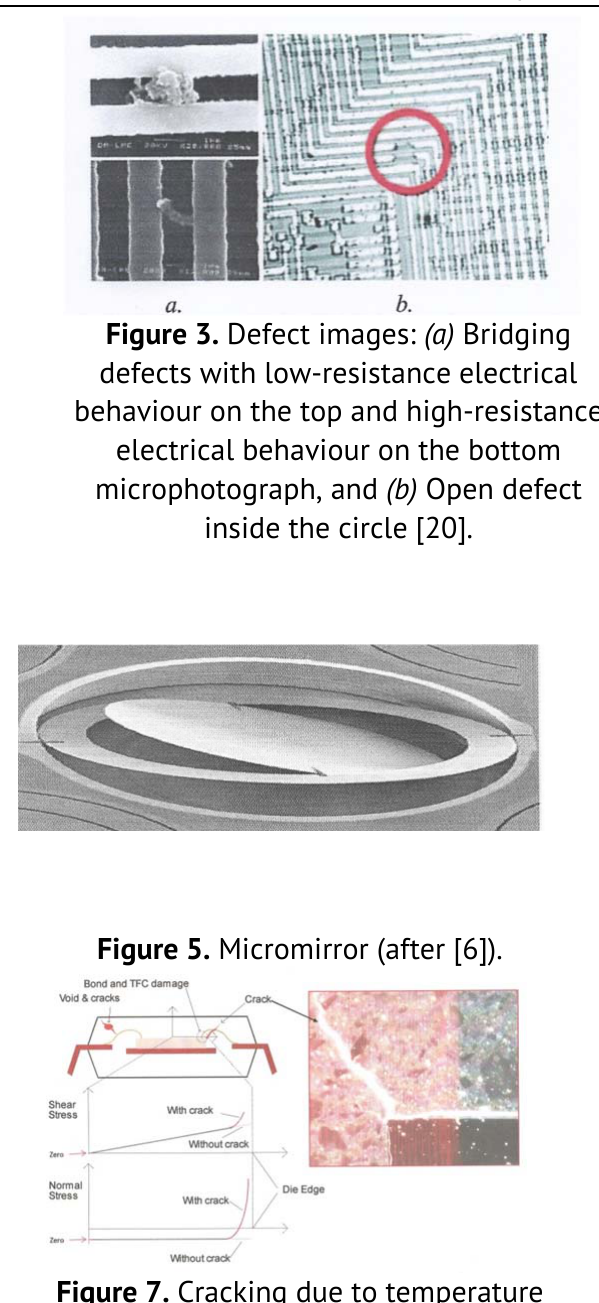
Figure 8. Moisture induced